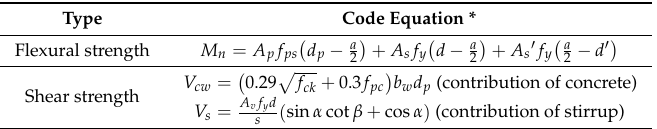
Table 3. Code equations for estimating the flexural and shear strength of the OPS